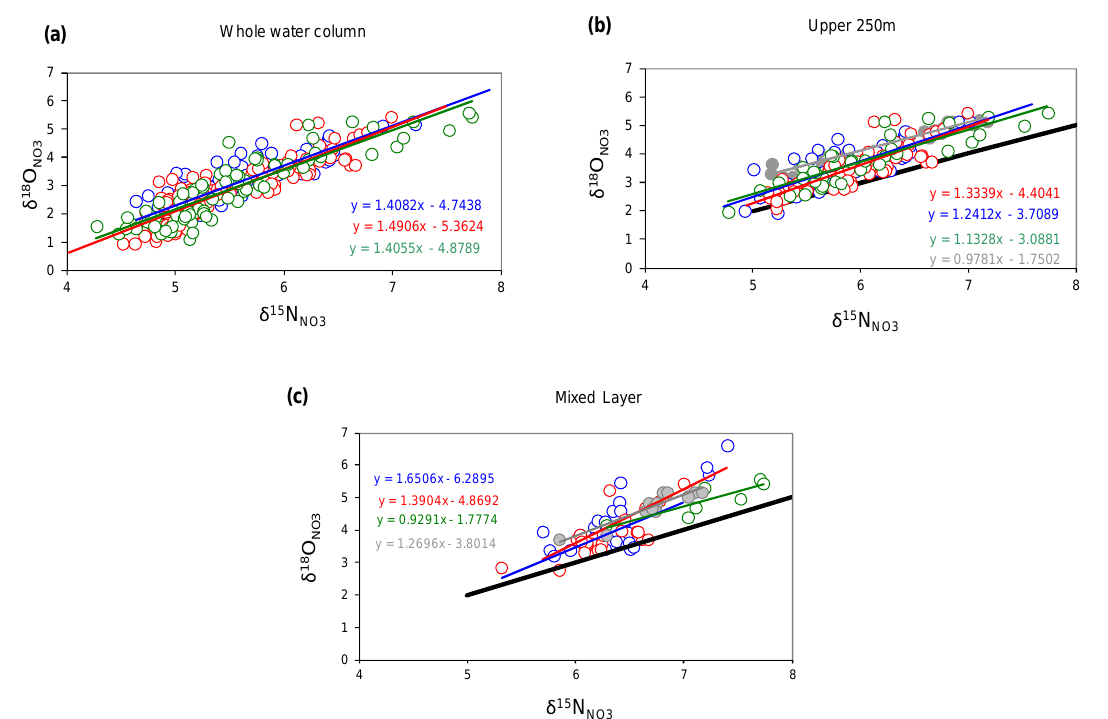
Figure 7. δ 18 O NO vs. δ 15 N NO ; blue: Plateau; red: Meander; green: Polar Front and north of PF: (a) whole water column; (b) upper 250m; 3 3 (c) mixed layer; grey circles represent the late season Plateau values recorded during KEOPS 1 (Trull et al., 2008); the black line with slope = 1 represents the evolution of reference deep water nitrate with δ 15 N NO and 18 O / 16 O fractionation factors are